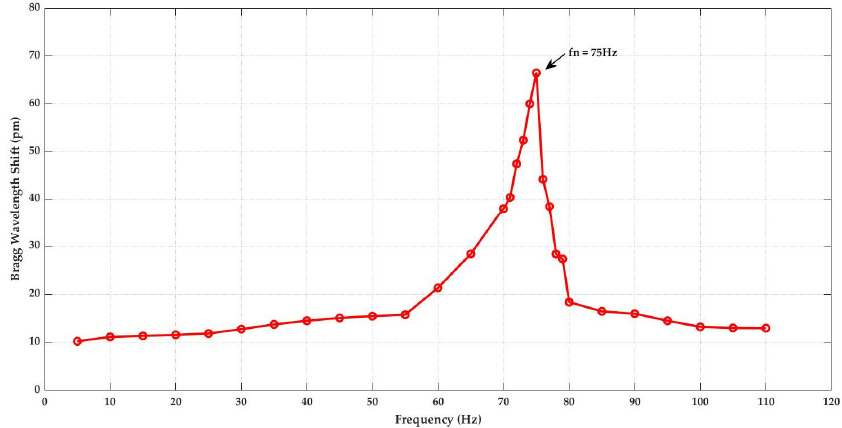
Figure 8. Amplitude ‐ frequency response of the FBG accelerometer. The dynamic sensitivity of the accelerometer was tested at room temperature. The wavelength shift corresponding to different g values at 20 Hz is shown in Figure 9 as dots, and the dashed line represents the linear fit. The slope of the linear fit gives the sensitivity of the sensor. The sensitivity of the sensor calculated from this experiment with fit coeffi ‐ cient R 2 = 0.998 at 10 Hz, 20 Hz, 30 Hz, and 40 Hz are ±435.1 pm/g, ±434.6 pm/g, ±409.3 pm/g and ±455.8 pm/g. The average sensitivity of this FBG accelerometer calculated from this experiment is ±433.7 pm/g with a fit coefficient R 2 = 0.998.